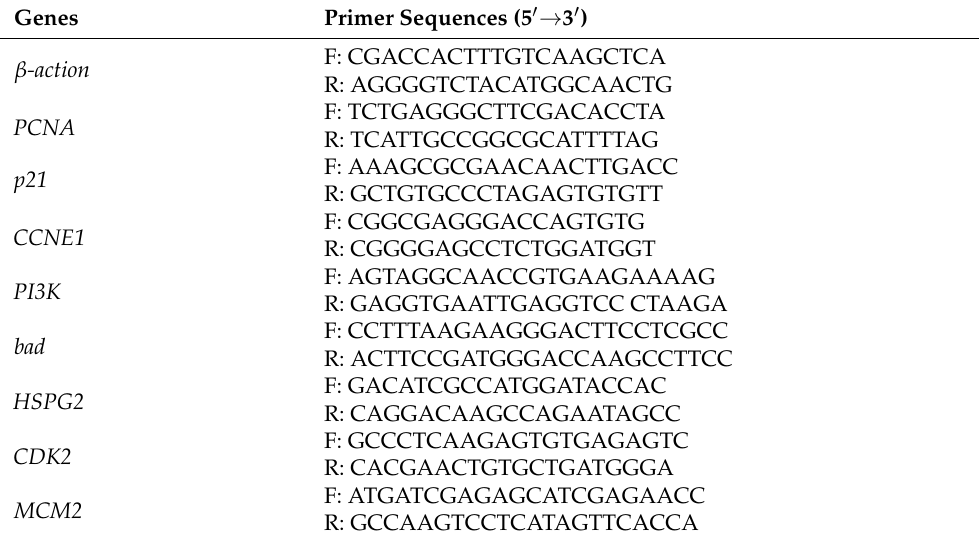
Table 2. Sequences of primers used in